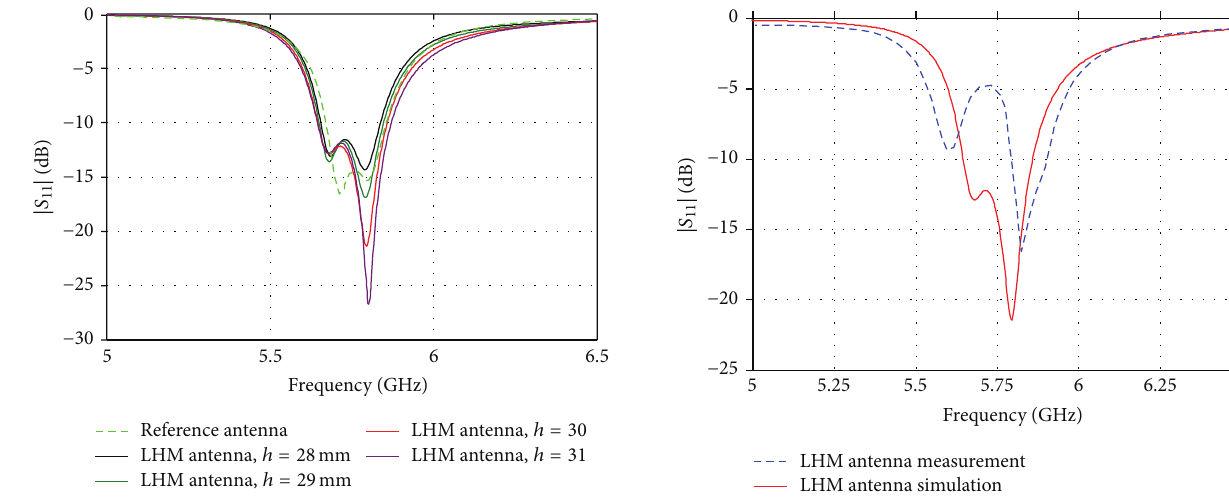
Figure 14: Reflection coefficients of antenna with varying air-gap height.